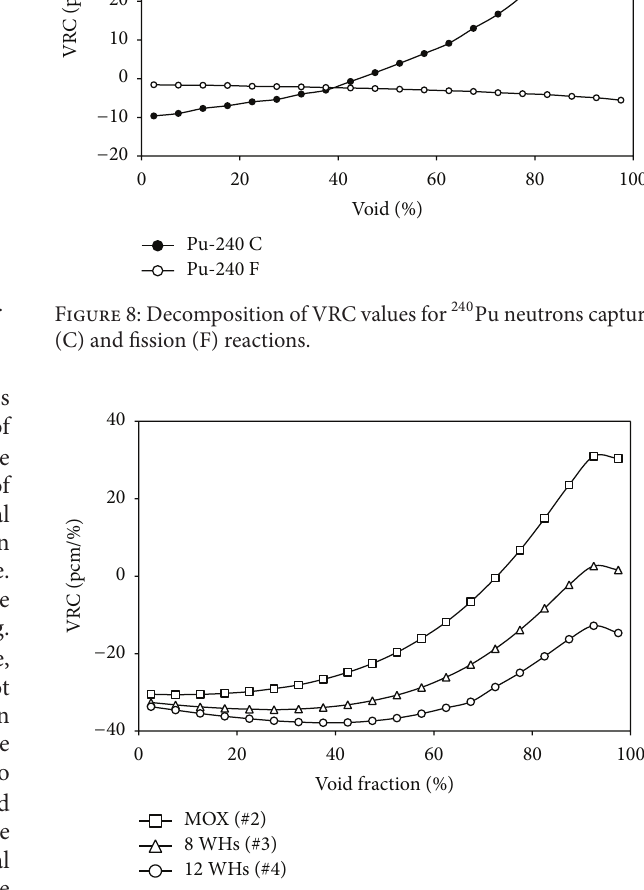
Figure 9: Void reactivity coefficient over void fraction for modified MOX fuel